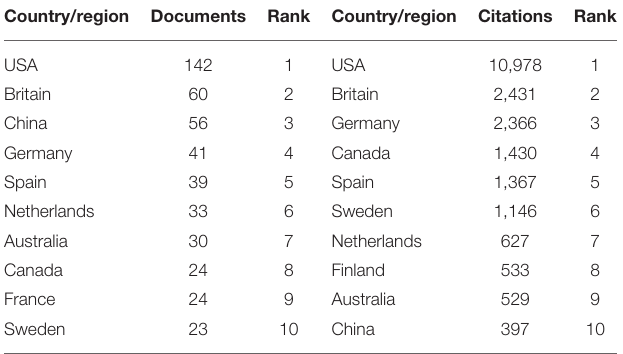
TABLE 2 | Top 10 countries/regions in number of documents and citations. Country/region Documents Rank Country/region Citations Rank